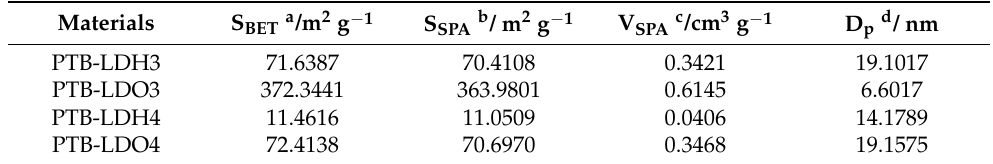
Table 1. Specific surface area, and pore volume parameters of PTB-LDH3, PTB-LDH4, PTB-LDO3 and PTB-LDO4.